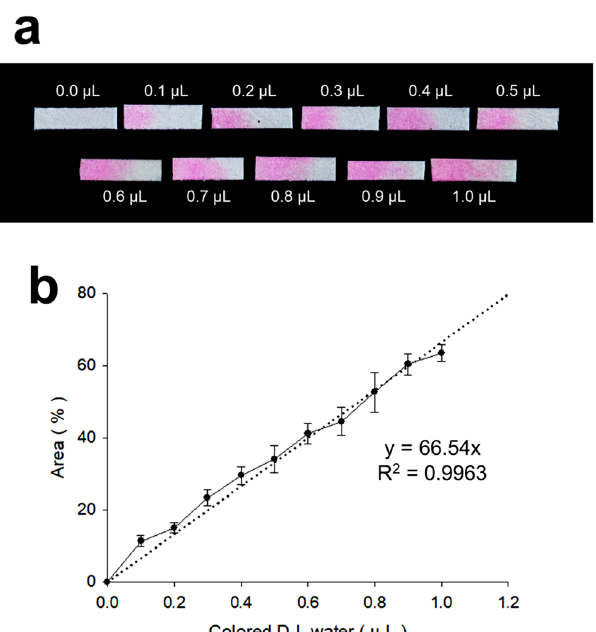
Figure 3. Quantification of a pink dye solution using the paper reservoir. ( a ) Digital image showing that as the solution volume increases to 0–1 μL at 0.1 μL intervals, the area of the solution in the paper storage is increased. ( b ) A graph showing the linearity of the solution volume and the ratio of the area occupied by the solution. Graph b presents average ± standard deviation based on 5 replicate